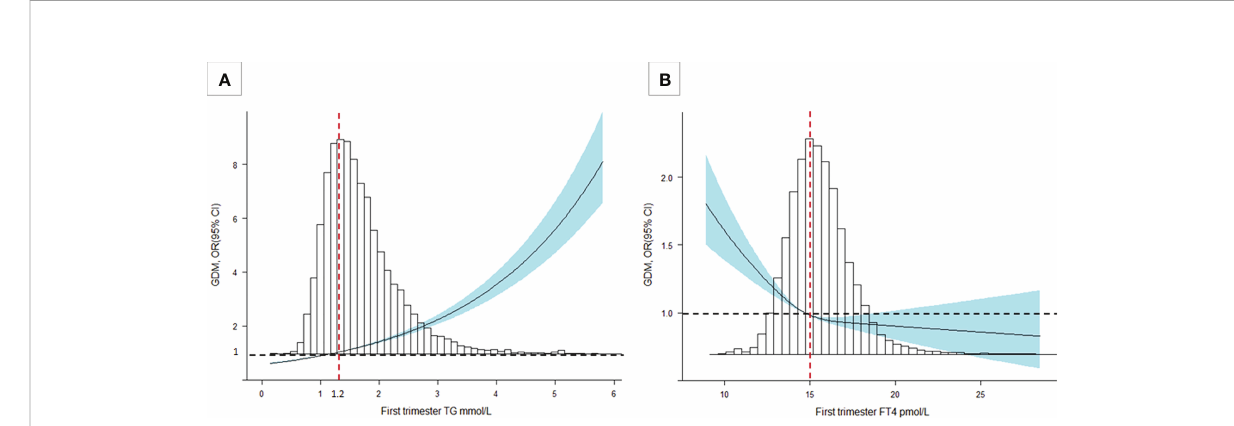
FIGURE 2 Cubic spline regression analysis of TG and FT4 levels with GDM risk. (A) A TG level of 1.2 mmol/L was selected as the reference level ( P <0.001). (B) An FT4 level of 15 pmol/L was selected as the reference level ( P <0.001). The lines indicate the estimated ORs, and the light blue-shaded areas represent the 95% CIs. All analyses were adjusted for maternal age, education level, family history of GDM, parity, TPOAb status, and prepregnancy